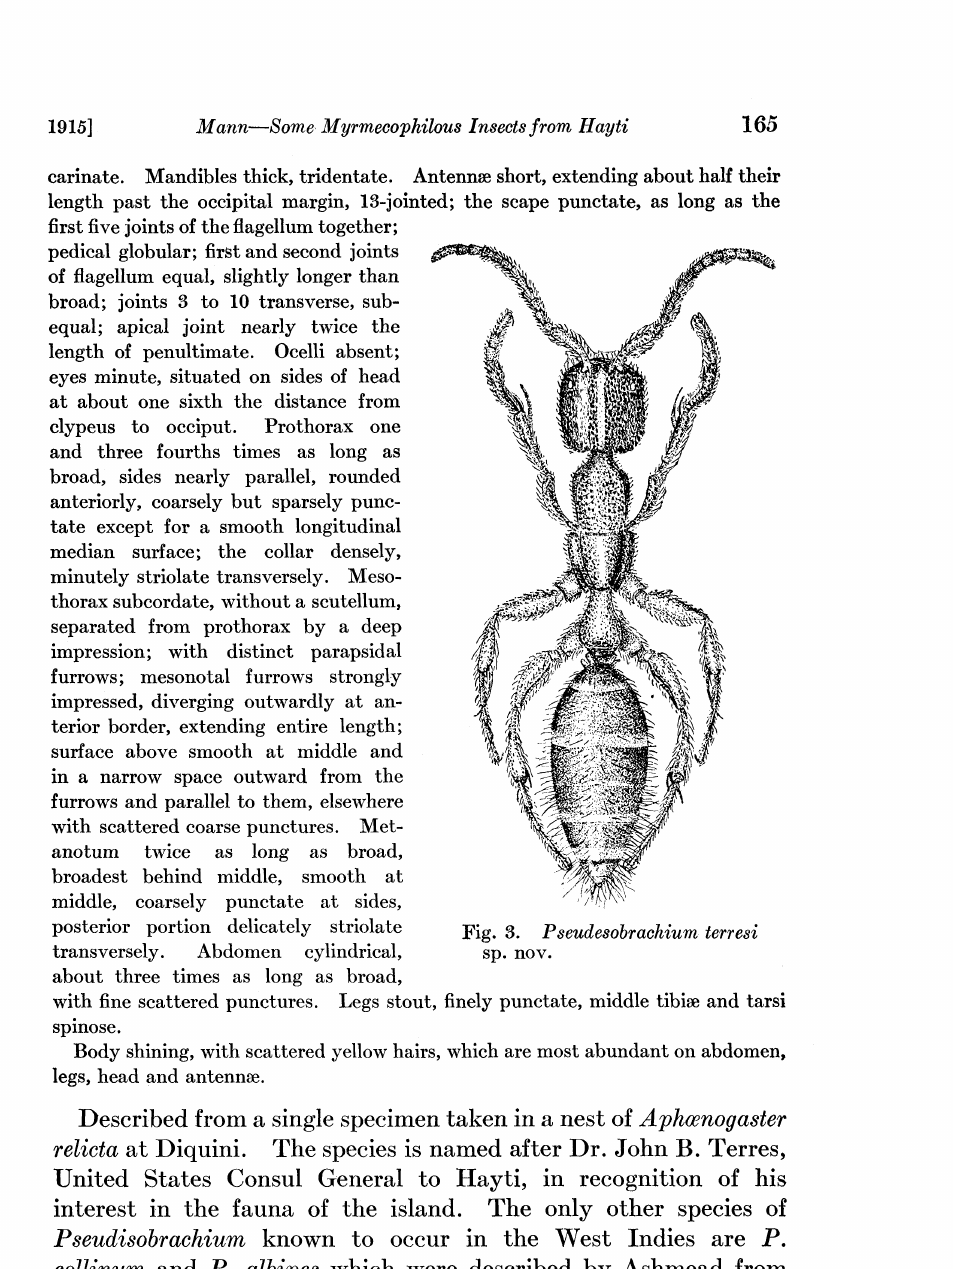
transversely. Abdomen cylindrical, sp. nov. about three times as long as broad, spinose. Body shining, with scattered yellow hairs, which are most abundant on abdomen, legs, head and